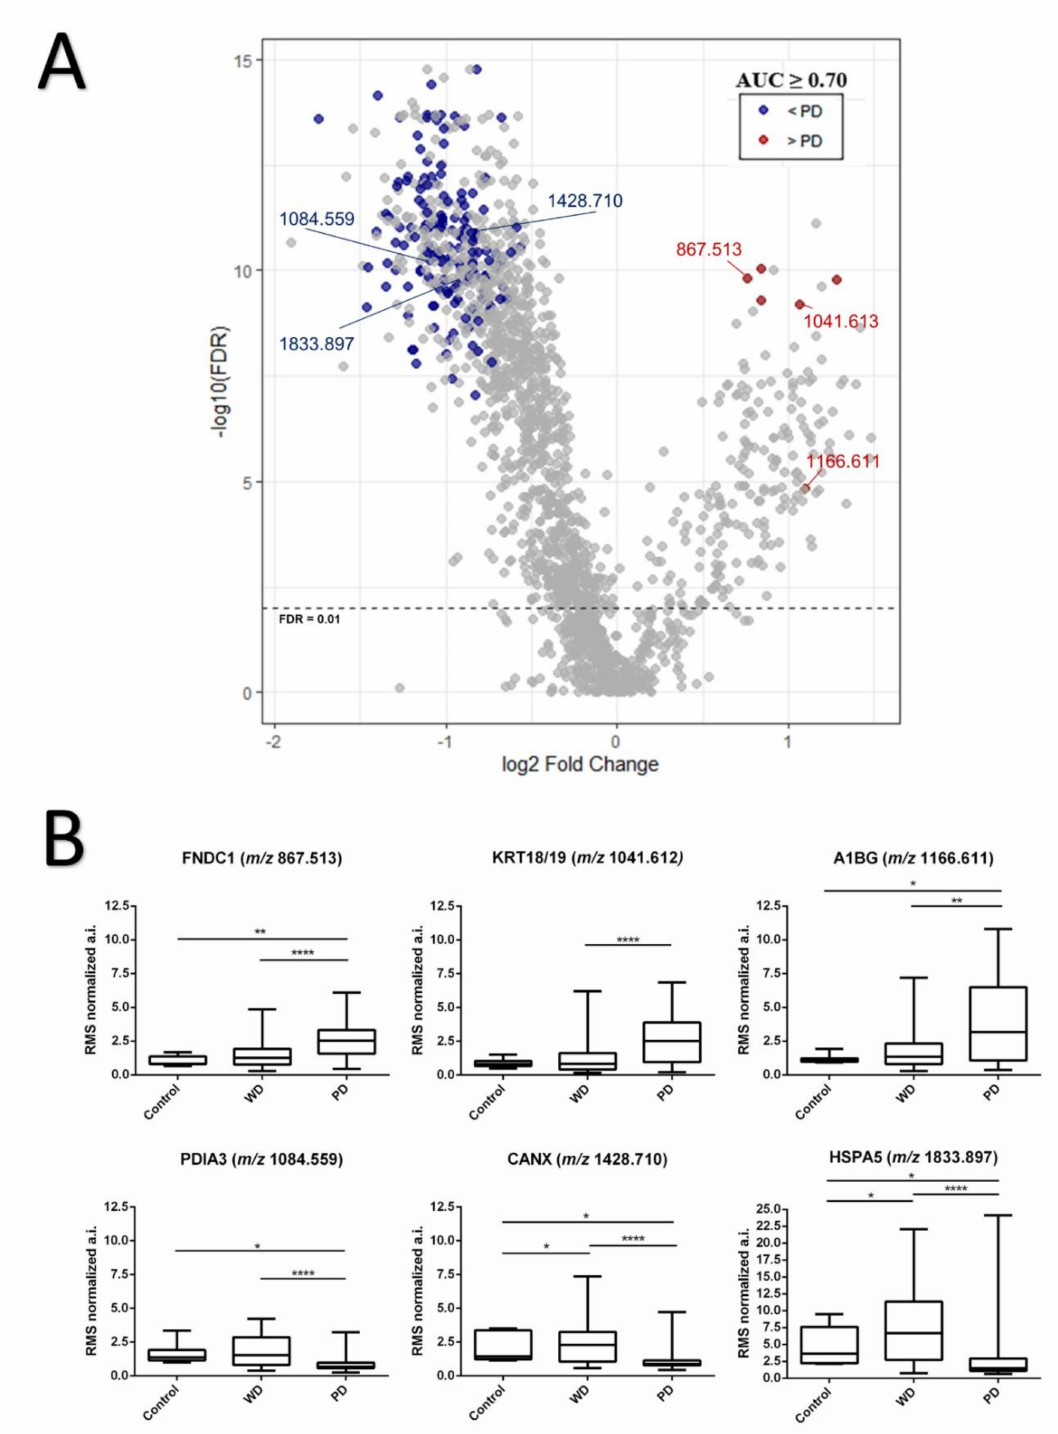
Figure 2. ( A ) Volcano plot shows the discriminative peaks (AUC ≥ 0.70 and FDR ≤ 0.05) in WD vs. PD group. Higher intensity levels in PD tumors are indicated in red, lower intensity levels are indicated in blue ( B ) Boxplot analysis of representative peptide expression of six discriminative m/z signals in canine mammary carcinoma tissues. Normalized absolute intensity data and error bars are shown for WD and PD tumor areas, as well as non-neoplastic mammary gland used as control. Ions at m/z 867.513, 1041.613, and 1166.611 were more expressed in PD ROIs, while signals at m/z 1084.559, 1428.710, and 1833.897 presented a lower expression in the same regions. (*) p < 0.05 (**) p < 0.01 (****) p < 0.0001. Protein identity assignment of the 168 discriminating features based on mass matching to the LC-MS/MS derived peptide database resulted in 38 proteins IDs with